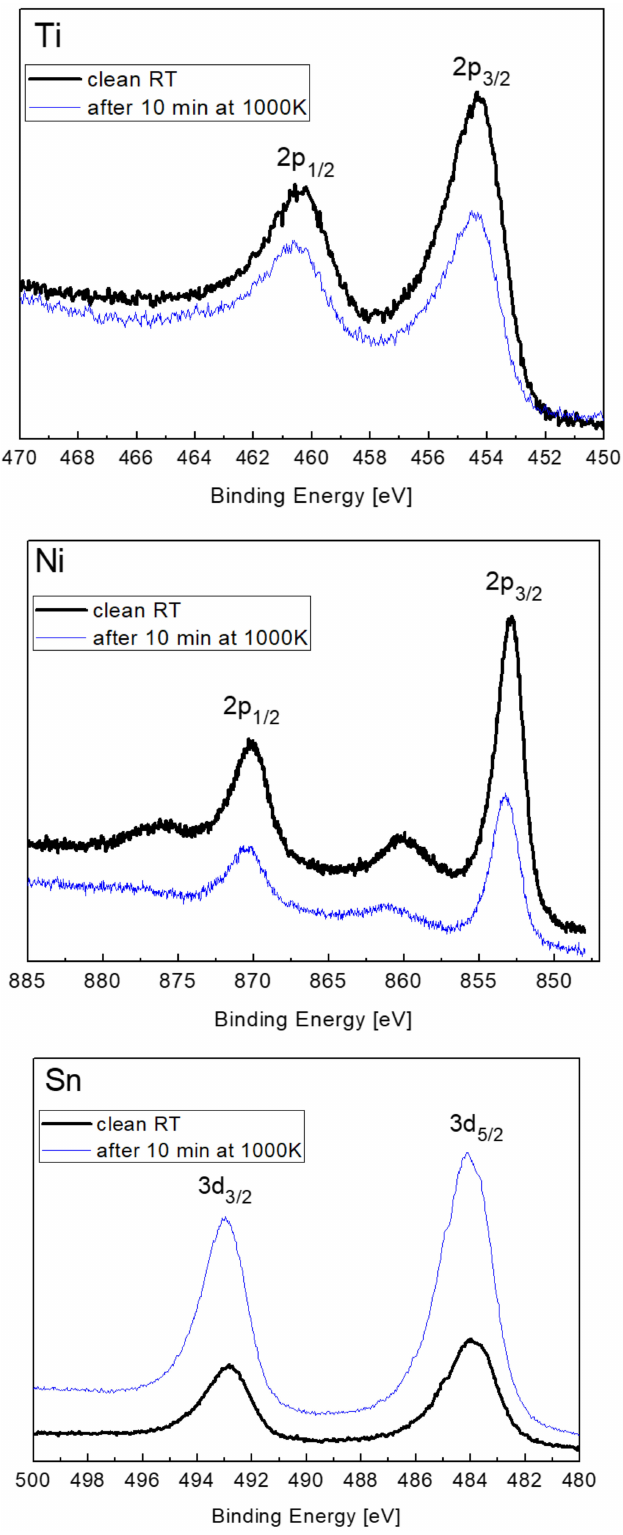
Figure 2. XPS survey scan of the alloy at room temperature and high-resolution spectra of the alloy components at room temperature and after heating (in vacuum) to 1000 K for 10 min (in arbitrary units). In order to evaluate the temperature dependence of the segregation, AES measurements were applied during the heating process (allowing much faster measurements relative to